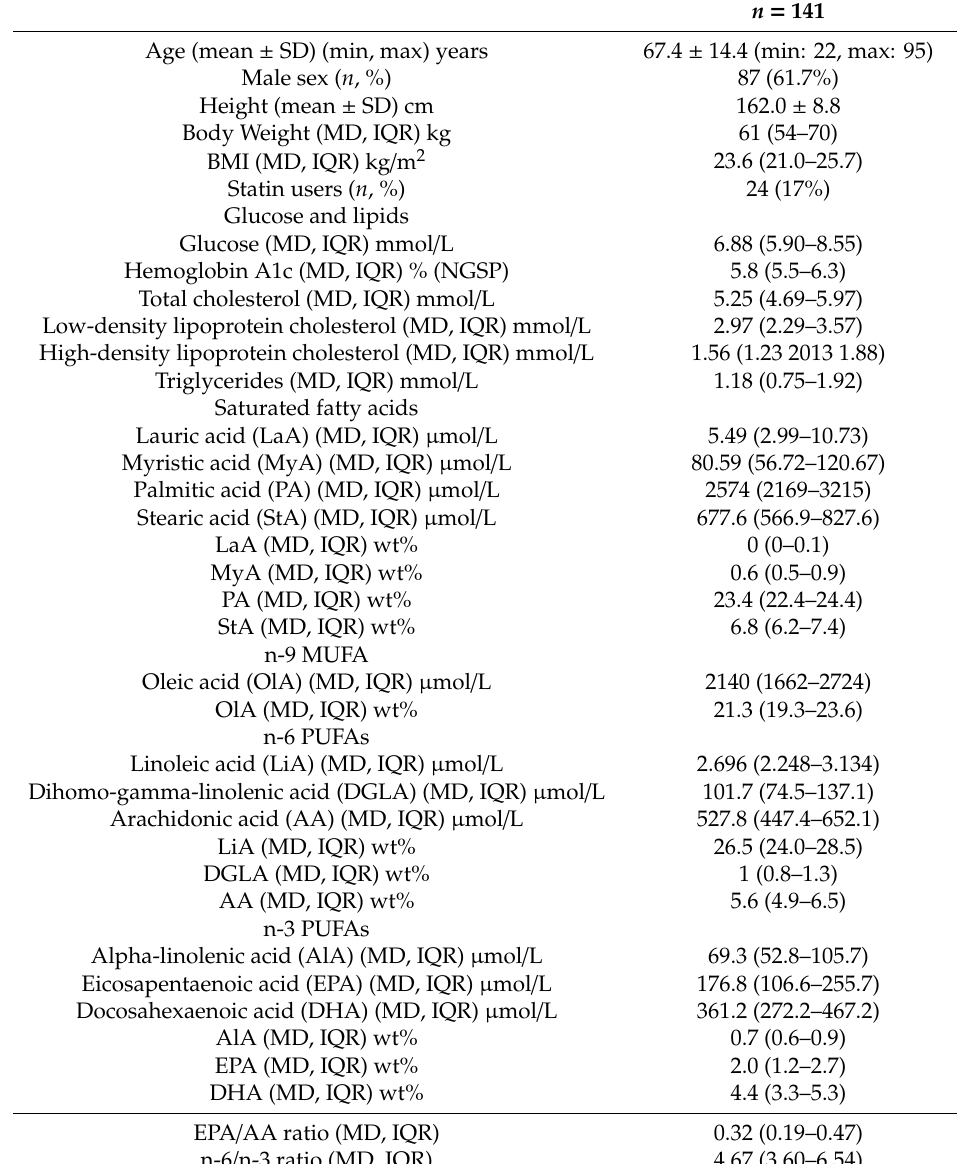
Table 1. Patient